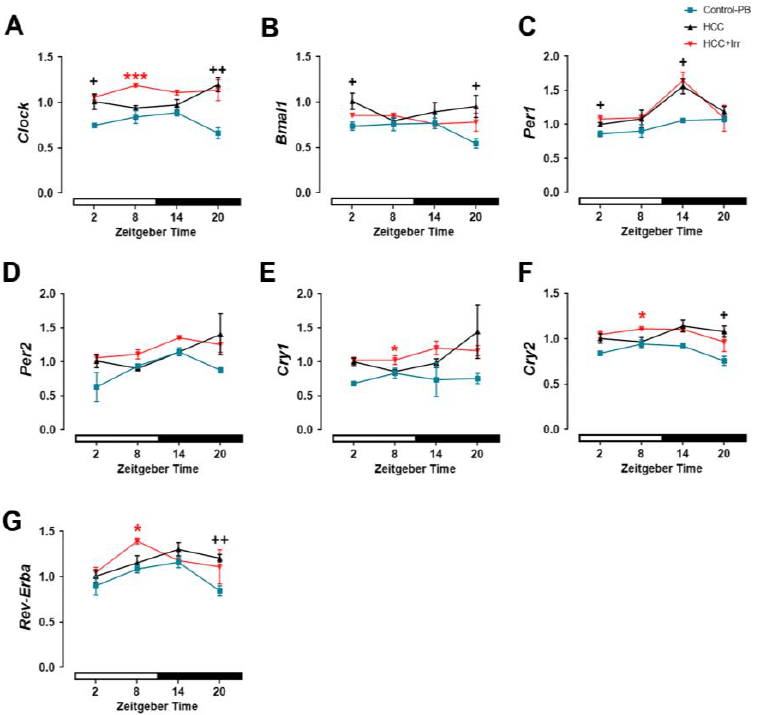
Figure 4. Effect of HCC and radiotherapy on clock gene expression in the mouse hippocampus. ( A ) Relative expression of Clock mRNA. ( B ) Relative expression of Bmal1 mRNA. ( C ) Relative expression of Per1 mRNA. ( D ) Relative expression of Per2 mRNA. ( E ) Relative expression of Cry1 mRNA. ( F ) Relative expression of Cry2 mRNA. ( G ) Relative expression of Rev-Erba mRNA. Black crosses indicate differences between HCC mice and control-PB. Red asterisks indicate differences between HCC and HCC+Irr. *, +: p < 0.05, ++: p < 0.01, ***: p < 0.001. White and black bars indicate the day/rest phase and night/activity phase, respectively. n = 12 mice per group, 3 mice at each time point. Control-PB: control mice given phenobarbital (PB) in drinking water. HCC: HCC-bearing mice. HCC+Irr: HCC-bearing irradiated mice. Brain Muscle Arnt-like protein-1 ( Bmal1 ). Period genes ( Per1, 2 ). Cryptochrome genes ( Cry1, 2 ).